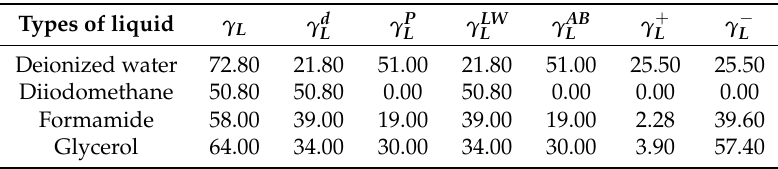
Table 1. Surface free energy parameters of control liquid (mJ/m 2